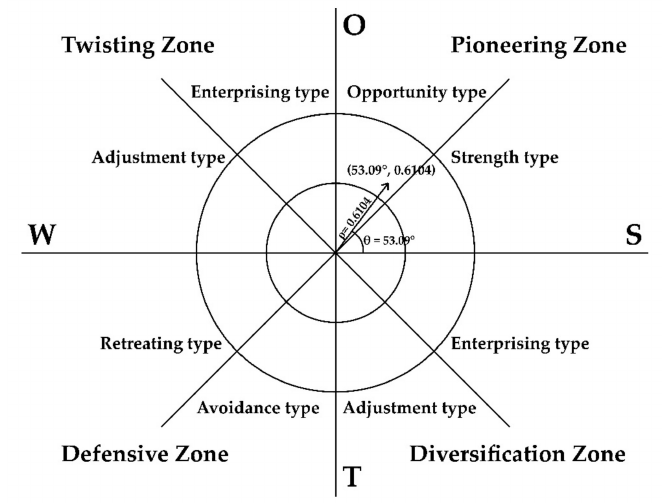
Figure 3. Strategic type and strategic intensity